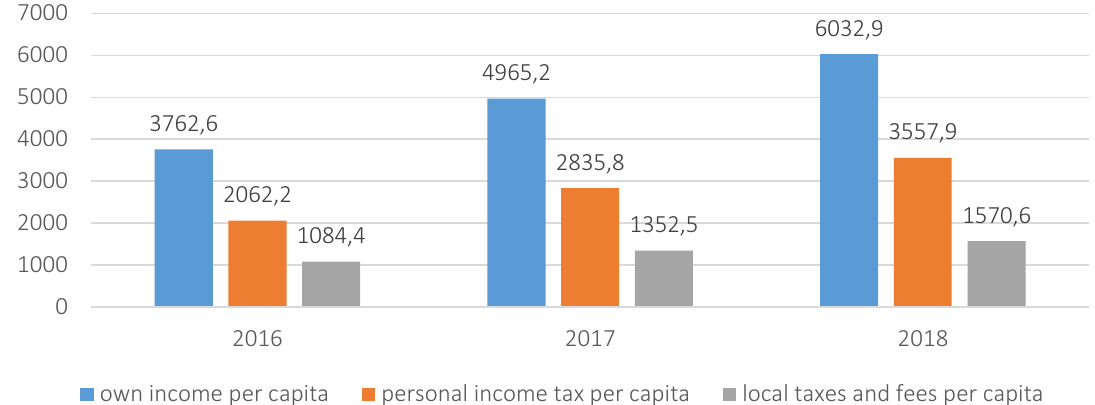
Figure 2. Own revenues of general local budgets fund per